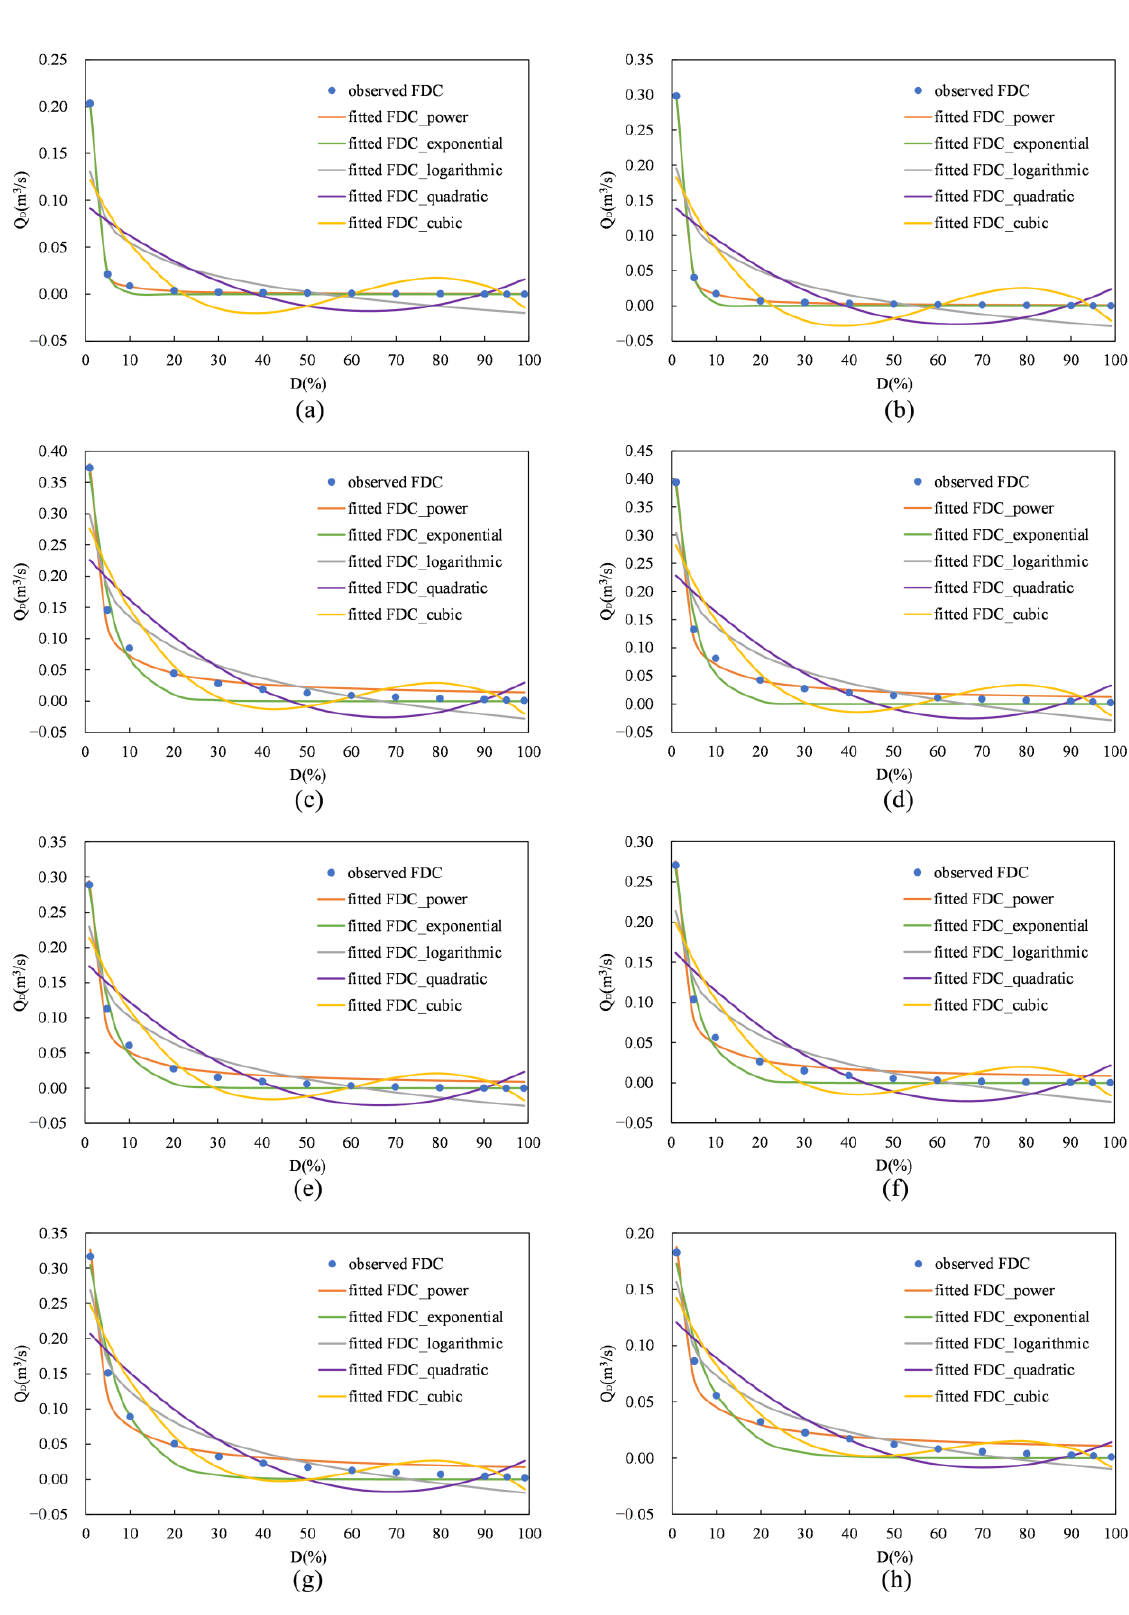
Figure 3. Five fitting equations of FDCs of eight basins from different NSE values: ( a ) Zhumadian (ID. 11 in Figure 1 & Table 2), ( b ) Lixin (ID. 6), ( c ) Tunxi (ID. 28), ( d ) Qiulu (ID. 54), ( e ) Jiangwan (ID. 48), ( f ) Shuangjiangxi (ID. 56), ( g ) Shanjian (ID. 40), and ( h ) Laoshikan (ID. 41).